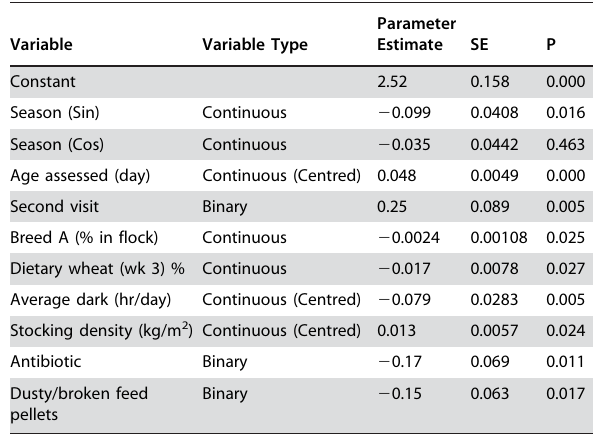
Table 3. The parameter estimates, their standard error and